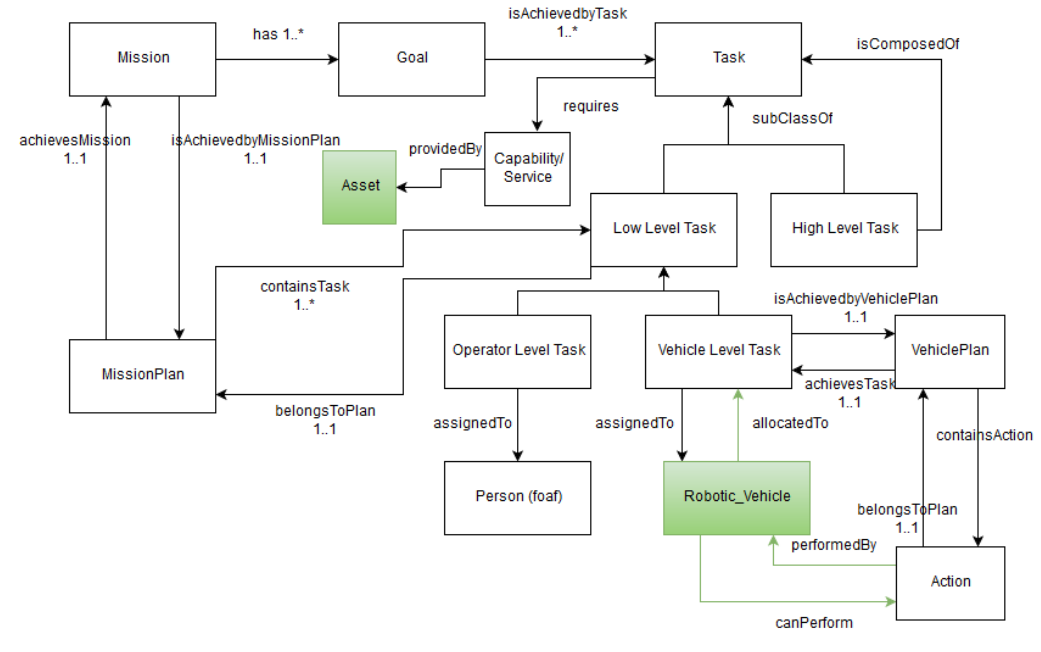
Figure 5. The mission and planning ontology.